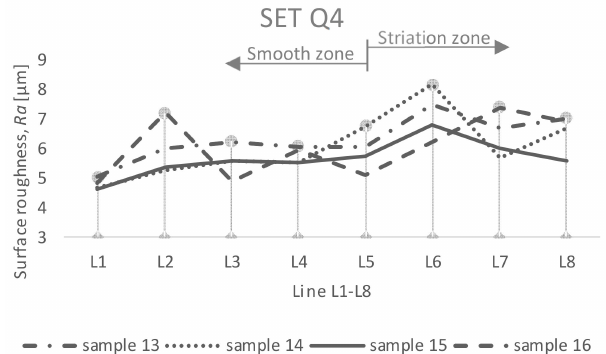
Figure 8. Evaluation of surface topography created by the AWJ (set Q4).